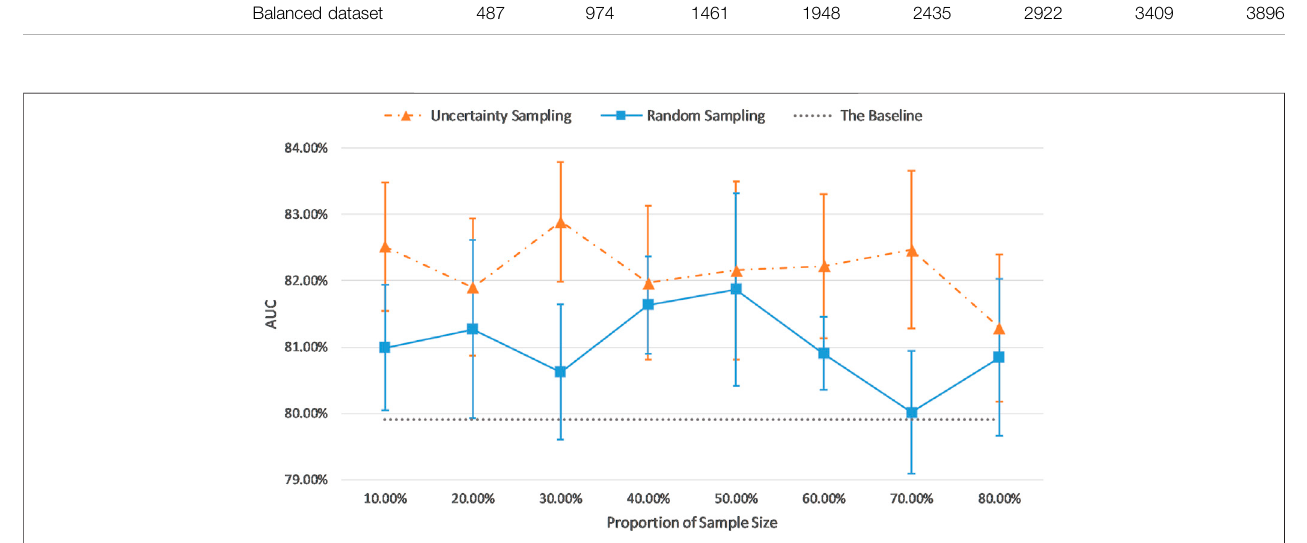
FIGURE 7 | Comparison of test AUC results of the uncertainty sampling method and random sampling method on the imbalanced dataset.